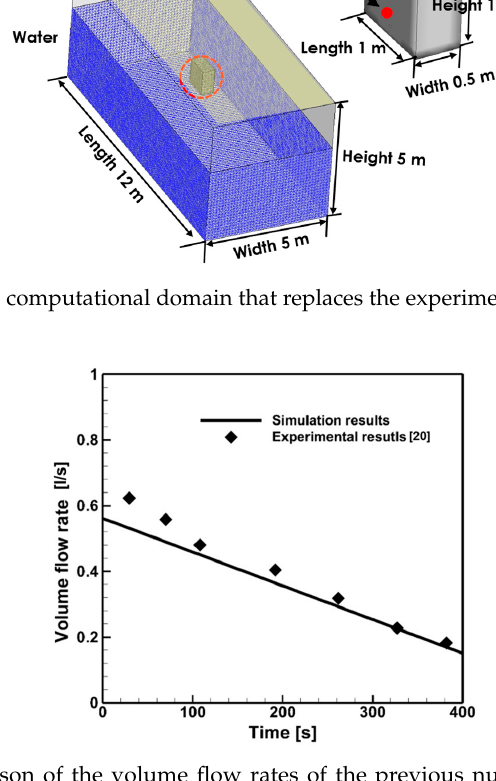
Figure 3. The comparison of the volume flow rates of the previous numerical and experimental results [20].